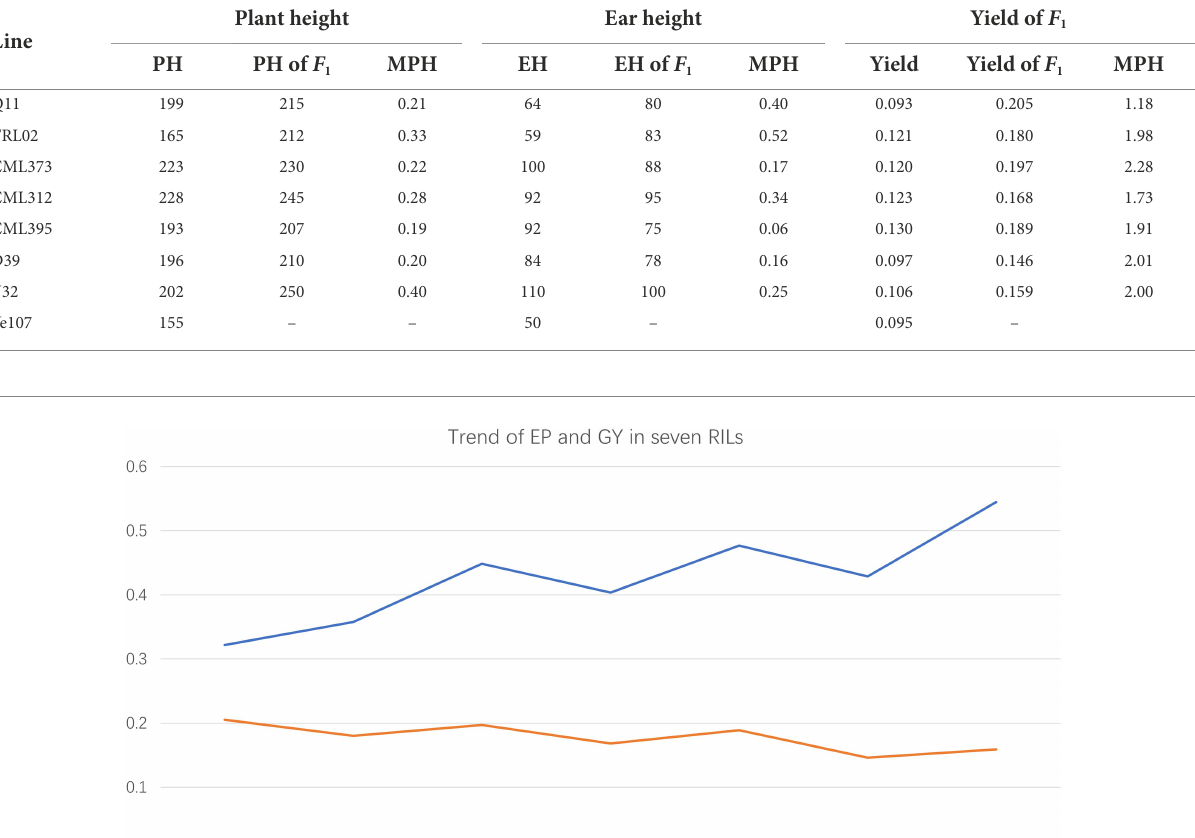
TABLE 2 The mid-parent heterosis of plant height, ear height and yield for each recombinant inbred line population.